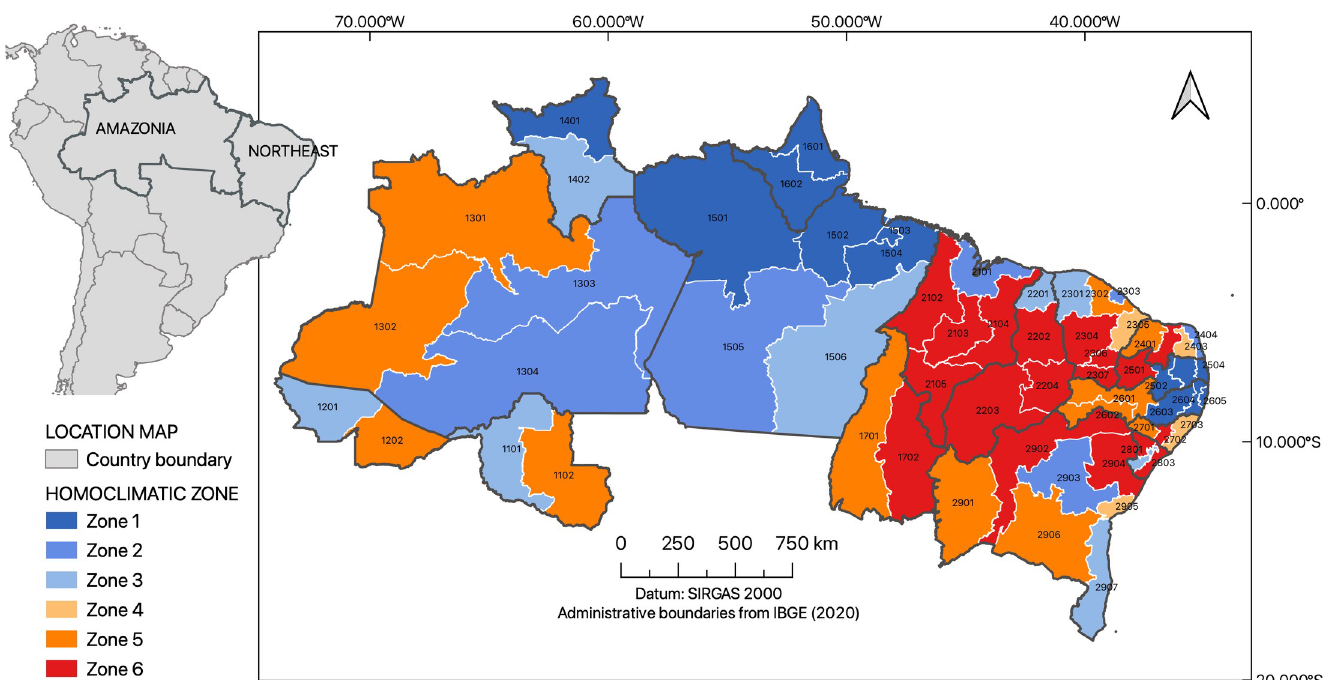
Fig 1. Spatial distribution of homoclimatic zones across the mesoregions in the Brazilian Amazon and in the Northeast.